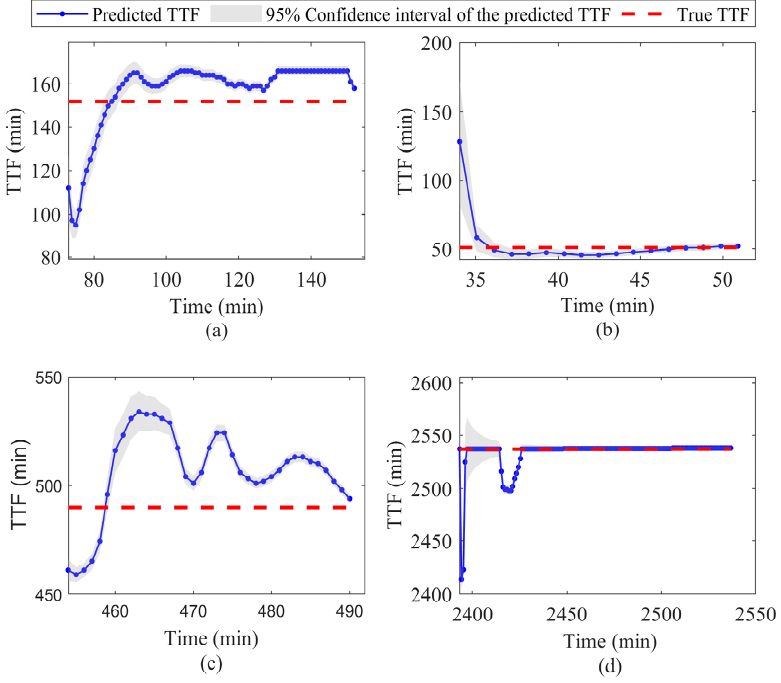
Figure 7. TTF prognostic results and its 95% confidence interval of ( a ) bearing 1_3, ( b ) bearing 1_5, ( c ) bearing 2_1, and ( d ) bearing 3_1.